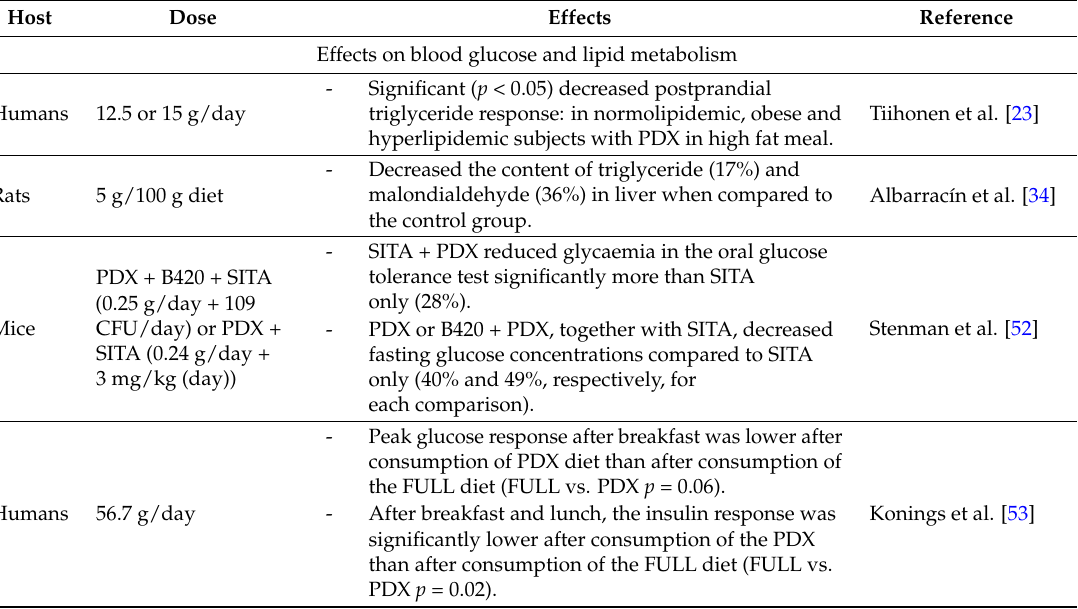
Table 4. The effects of administration of polydextrose on blood glucose and lipid